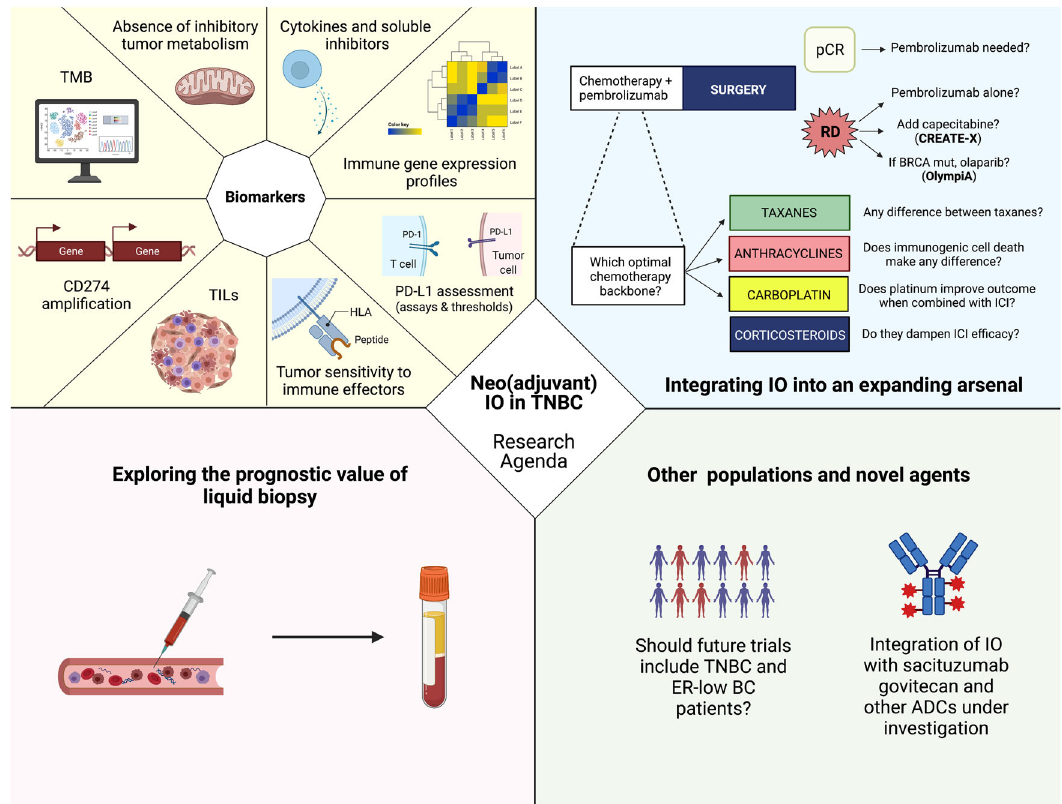
Fig. 1 Next decade research agenda for neo(adjuvant) immunotherapy in TNBC. Abbreviations: IO, immunotherapy, TNBC, triple negative breast cancer; TMB, tumor mutational burden; ADC, antibody-drug conjugate; ER, estrogen receptor; CD, cluster of differentiation; TILs, tumor in fi ltrating lymphocytes; PD-L1, Programmed death-ligand 1; HLA, human leukocyte antigen; PD-1, Programmed cell death protein 1; A, adenosine; T, thymine; C, cytosine; G, guanine; BRCA, BReast CAncer gene; EFS, event-freee survival; RD, residual disease; me1, mono- methylated form; BC, breast cancer. Created with